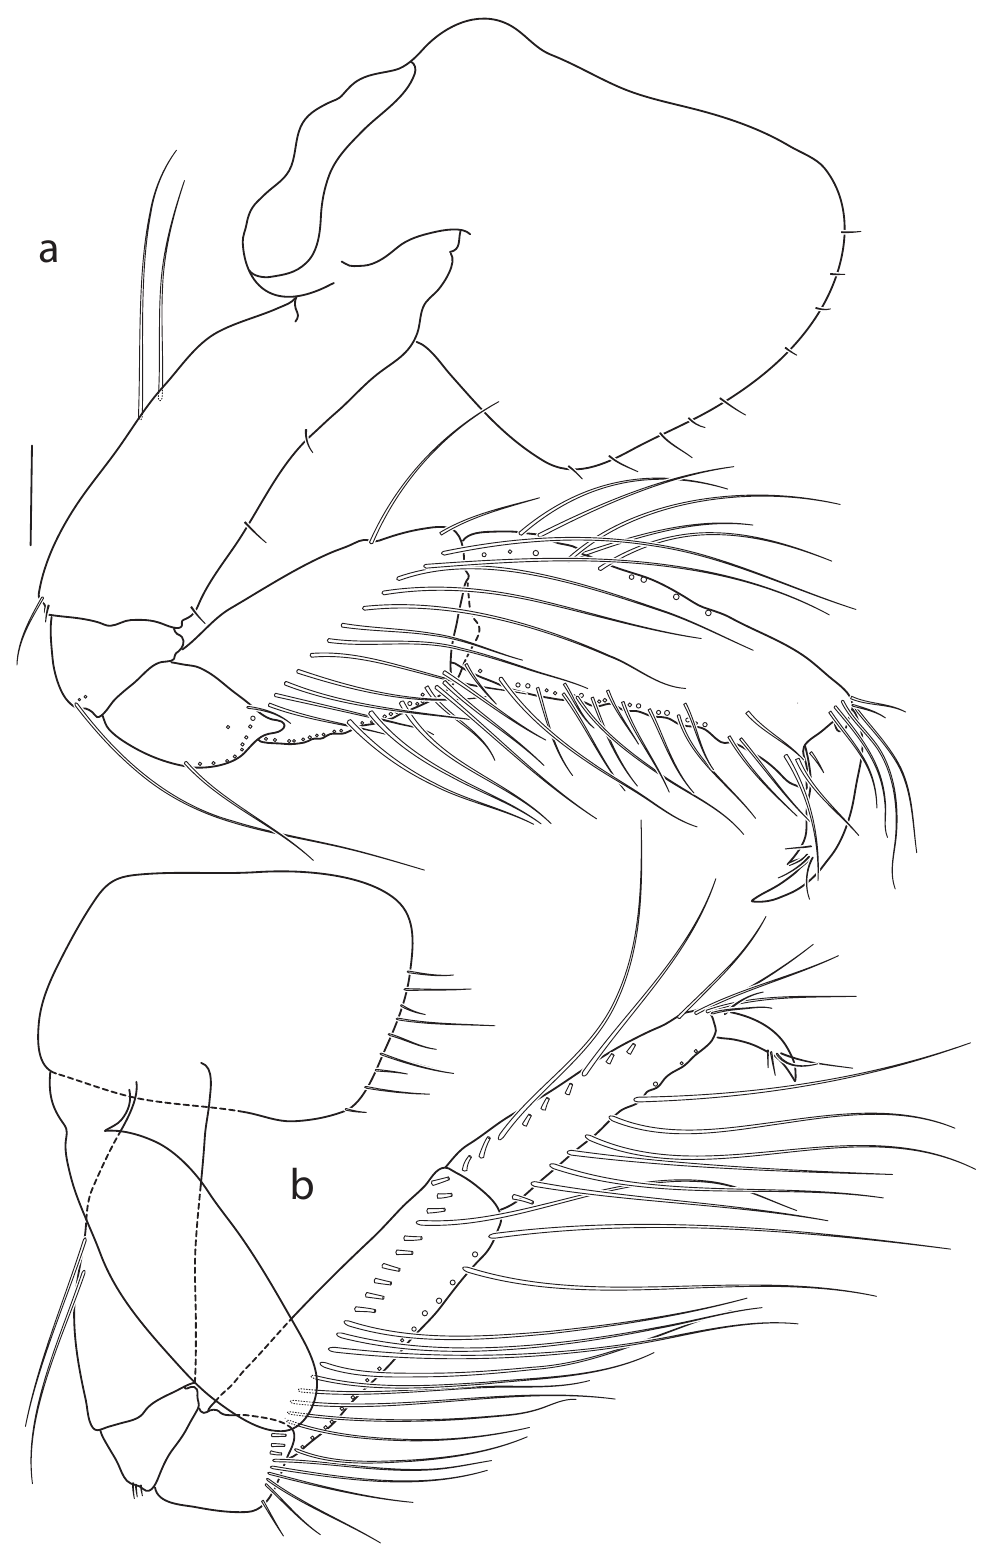
Fig. 9. Haplocheira barbimana robusta K.H. Barnard, 1932, ♂, 4.2 mm (ZMB 34098). a . Gnathopod 1. b . Gnathopod 2. Scale bars: a = 100 µm; b = 200